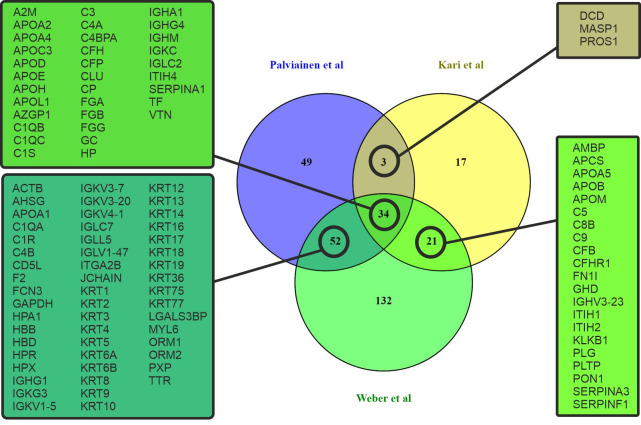
Venn diagram comparing the proteomic data of our study to a shared proteome from two previous studies of nanoparticle corona proteins accumulated from plasma [22, 38] showing a set of overlapping proteins, which suggests that a common corona proteome of plasma proteins accumulates on EVs and synthetic particles [22, 38].